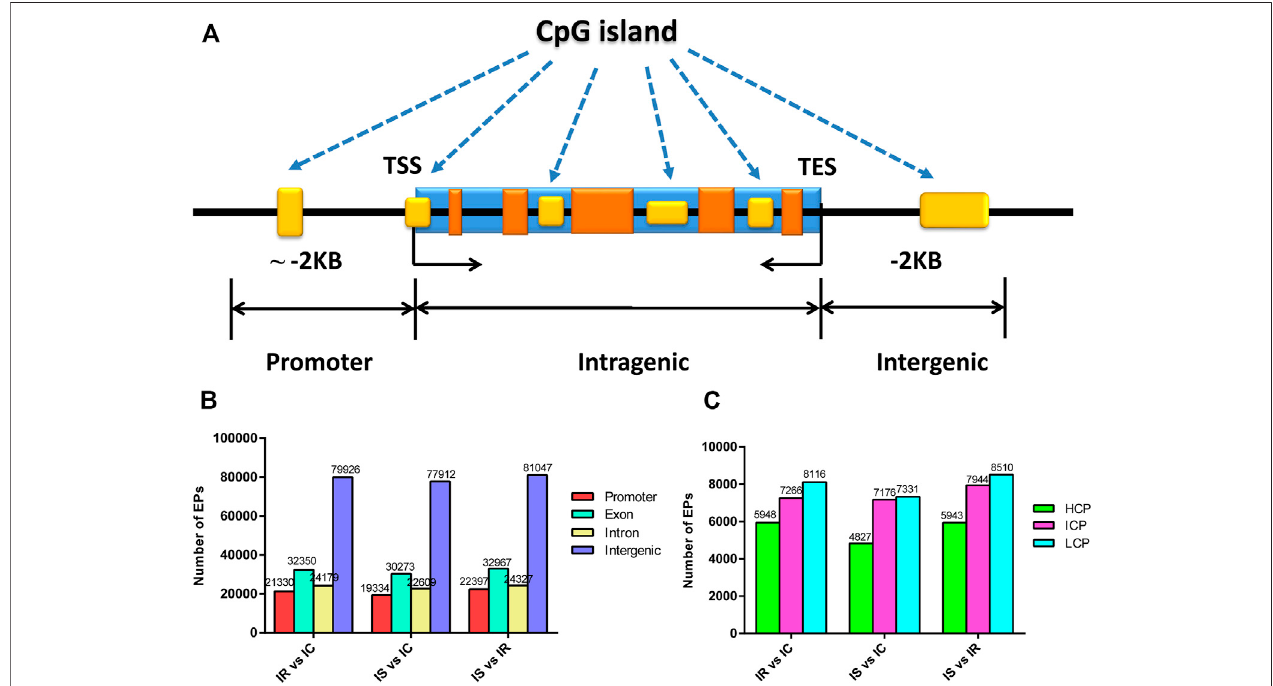
FIGURE 3 | Distribution of DNA methylation enrichment peaks in piglet ileum infected with C. perfringens type C infection. (A) Generic diagram showing CpG islands(CGIs)relativetogenetranscriptregions. (B) NumbersofMEPsintheCGIregionofIR,IS,andICgroups. (C) NumbersofMEPsinthepromoterCGIs.Note:HCP represents high CpG density promoter; ICP represents intermediate CpG density promoter; LCP represents low CpG density promoter.